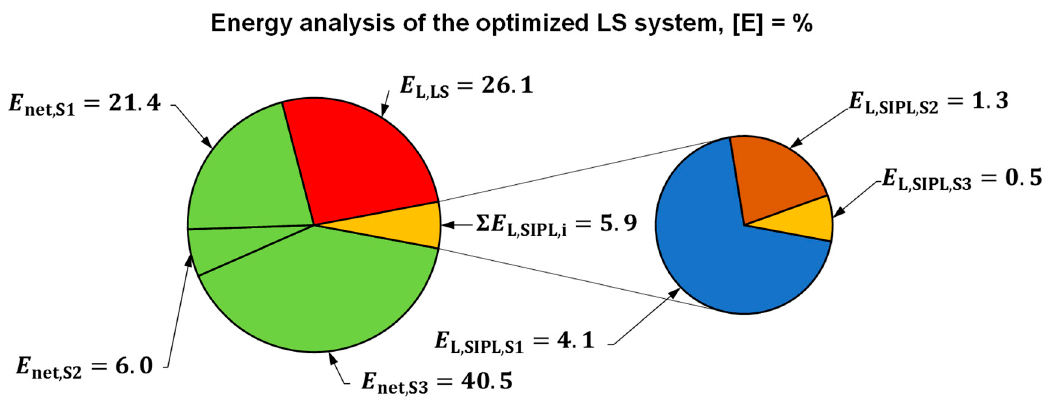
Figure 20. Energy analysis of the optimized LS system during the reference cycle. Previously published in [17]. Reproduced with permission from the publisher.